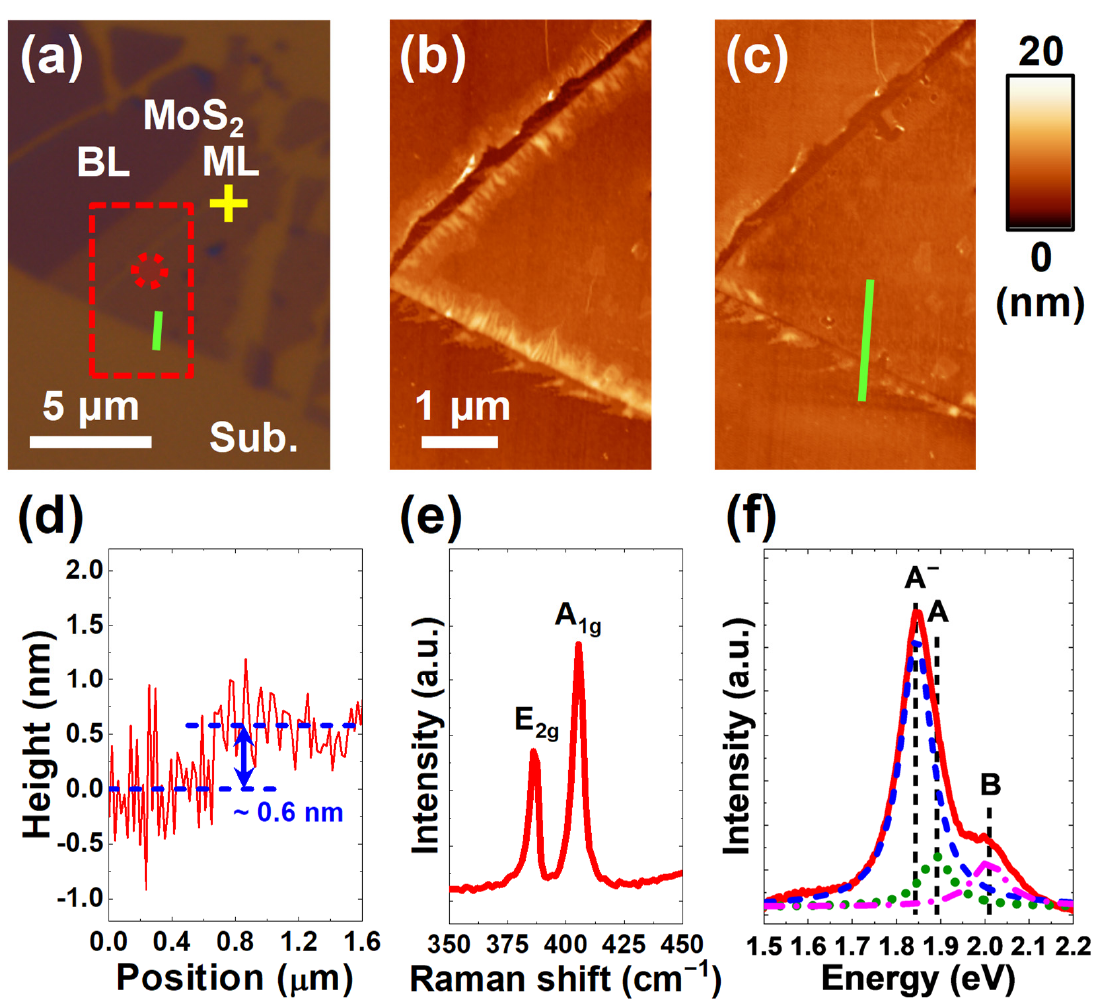
Figure 2. Surface morphology and optical characteristics of MoS 2 monolayer (ML) prepared by the mechanical exfoliation method: ( a ) An optical microscopy (OM) image to show the ML and bilayer (BL) regions of MoS 2 flakes on 300-nm-thick SiO 2 /Si substrates Sub. The red dashed circle indicates the spot on the ML region treated by the focused-laser irradiation (FLI). The images of atomic force microscopy (AFM) were taken ( b ) before and ( c ) after the FLI process. The region of the red dashed rectangular ( a ) was scanned for the AFM images. ( b , c ) are presented in the same scales. ( d ) The AFM line profile was scanned along the green segment marked in ( a , c ) to confirm the irradiated MoS 2 flake to be ML-thick (~0.6 nm). ( e ) Typical ambient Raman and ( f ) photoluminescence (PL) spectra measured from the pristine ML-MoS 2 flake before the FLI process. The spot for spectrum acquisition is marked with the yellow cross in ( a ). In ( f ), based on the Lorentzian curve fitting, the PL spectrum can be de-convoluted to three subsidiary peaks (sub-peaks) contributed from the radiative recom- bination processes involved with neutral excitons (A), negatively charged excitons (also referred to as trions) (A − ), and spin-orbit interactions (B), respectively.